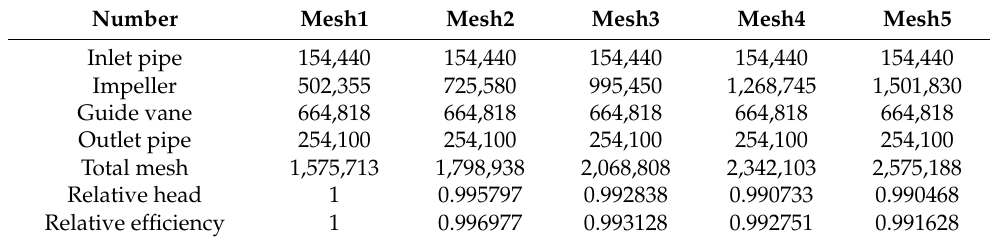
Table 1. Independence test of mesh number.